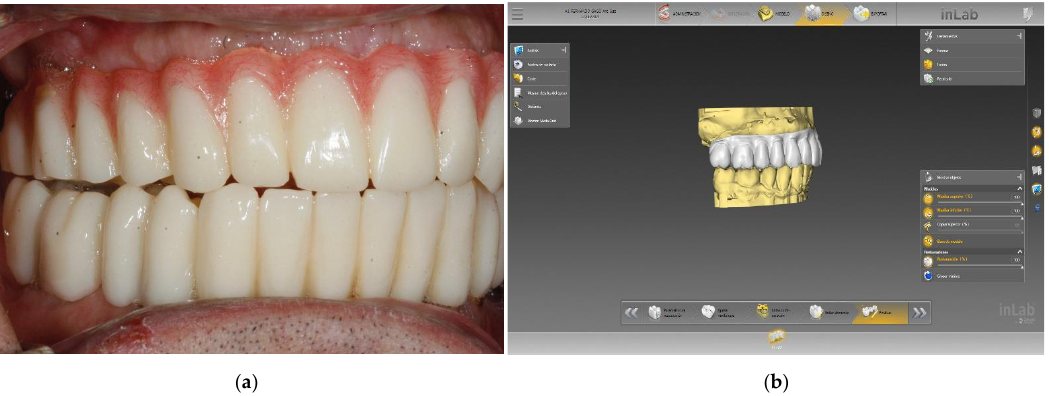
Figure 2. Clinical example of PMMA (Telio CAD Ivoclar-Vivadent, Schaan, Liechtenstein) used in an implant for temporary rehabilitation: ( a ) Lateral clinical view of the definitive prosthesis placed over five implants, ( b ) View of the design software used in this clinical case (inLab CAD Dentsply Sirona, York, PA, USA).